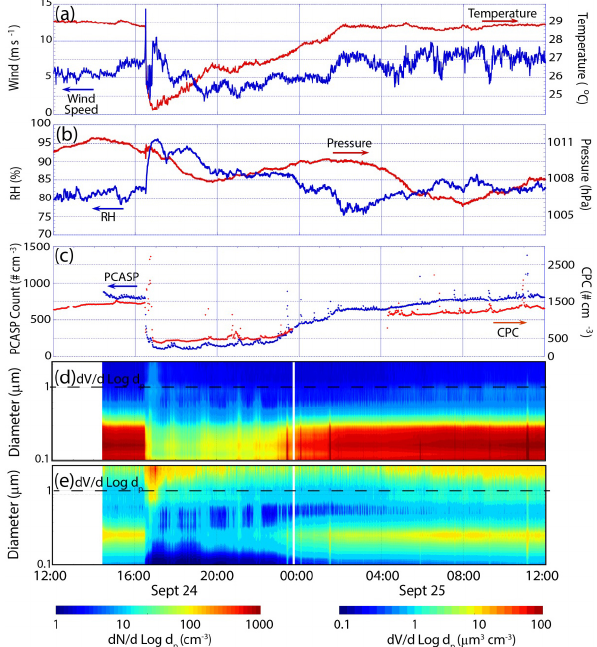
Figure 10. 24h times series of meteorology and aerosol parameters centered on the 24 September cold pool event. Tines are in UTC. (a) 1min temperature and wind speed; (b) 1min relative humidity and pressure; (c) PCASP and CPC total aerosol particle count; (d) and (e) PCASP number and volume distributions,